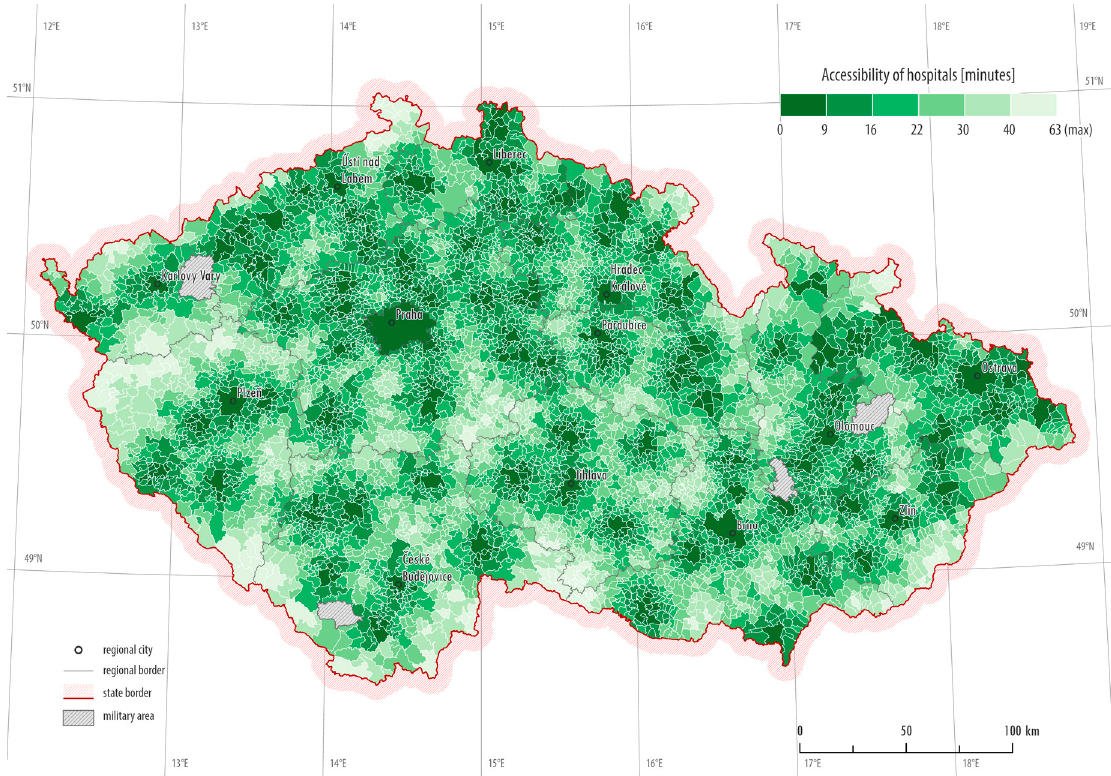
Figure A4. Accessibility of health care